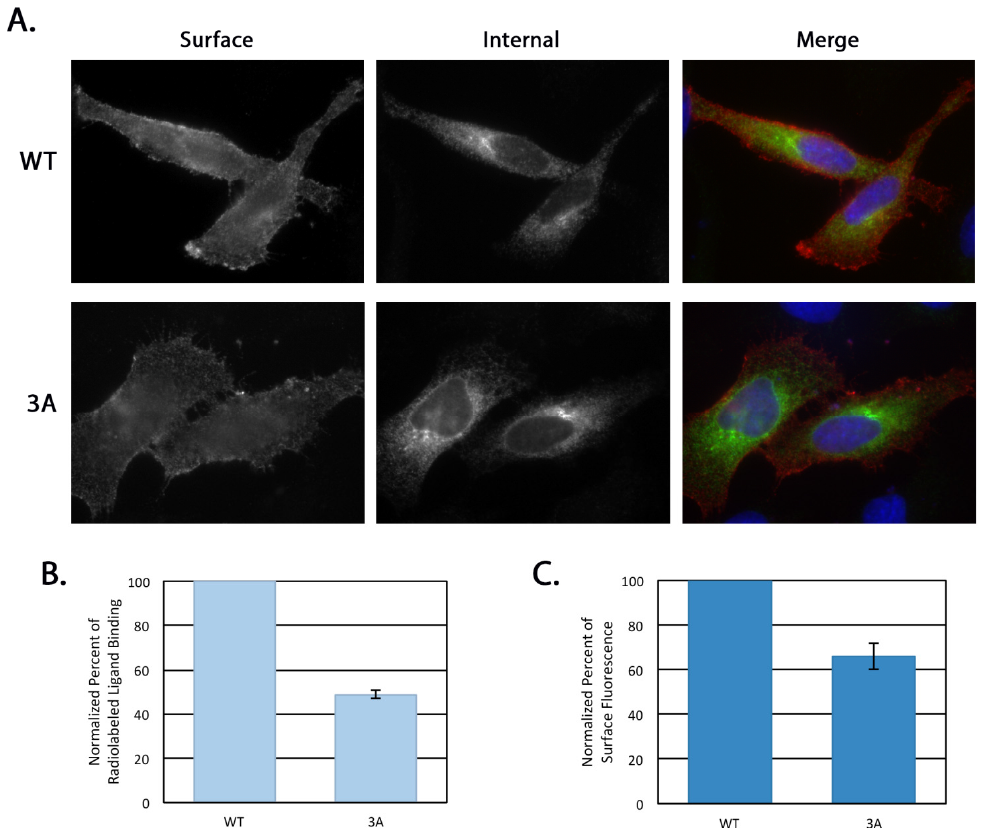
Figure 6. Steady state surface levels of β 1AR 3A are decreased compared to β 1AR